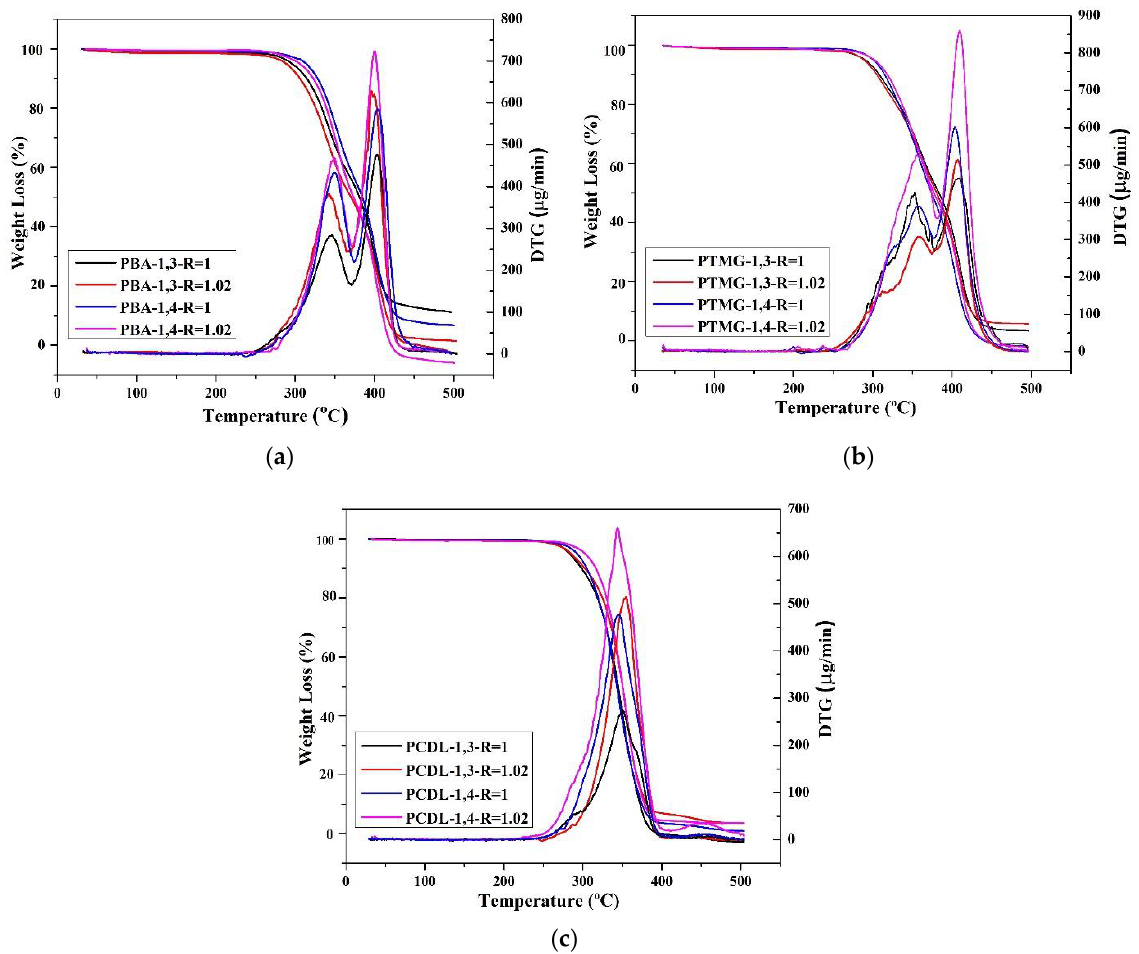
Figure 2. Thermogravimetric analysis (TGA) and differential thermogravimetry (DTG) spectra of TPU prepared through the polymerization of PBA ( a ), PTMG ( b ), or PCDL ( c ), with 1,3-BDO or 1,4-BDO.